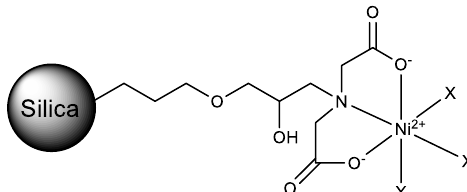
Figure 4. Structure of the IMAC material [6]. X, available orbitals for electron donors (water, imidazole, etc.).